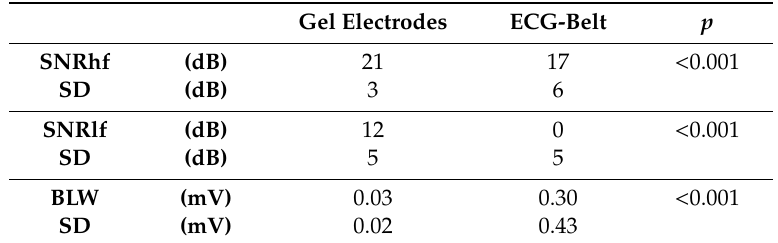
Table 2. Mean values for a signal to noise ratio for low (SNRlf) and high-frequency noise (SNRhf), as well as baseline wander (BLW).